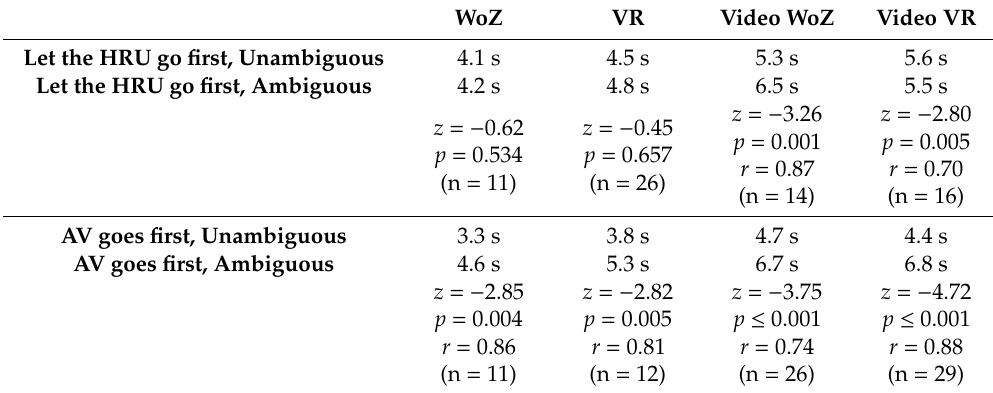
Table 9. Median ( Mdn ) of the IRT (measured in seconds), segregated by setup. WoZ VR Video WoZ